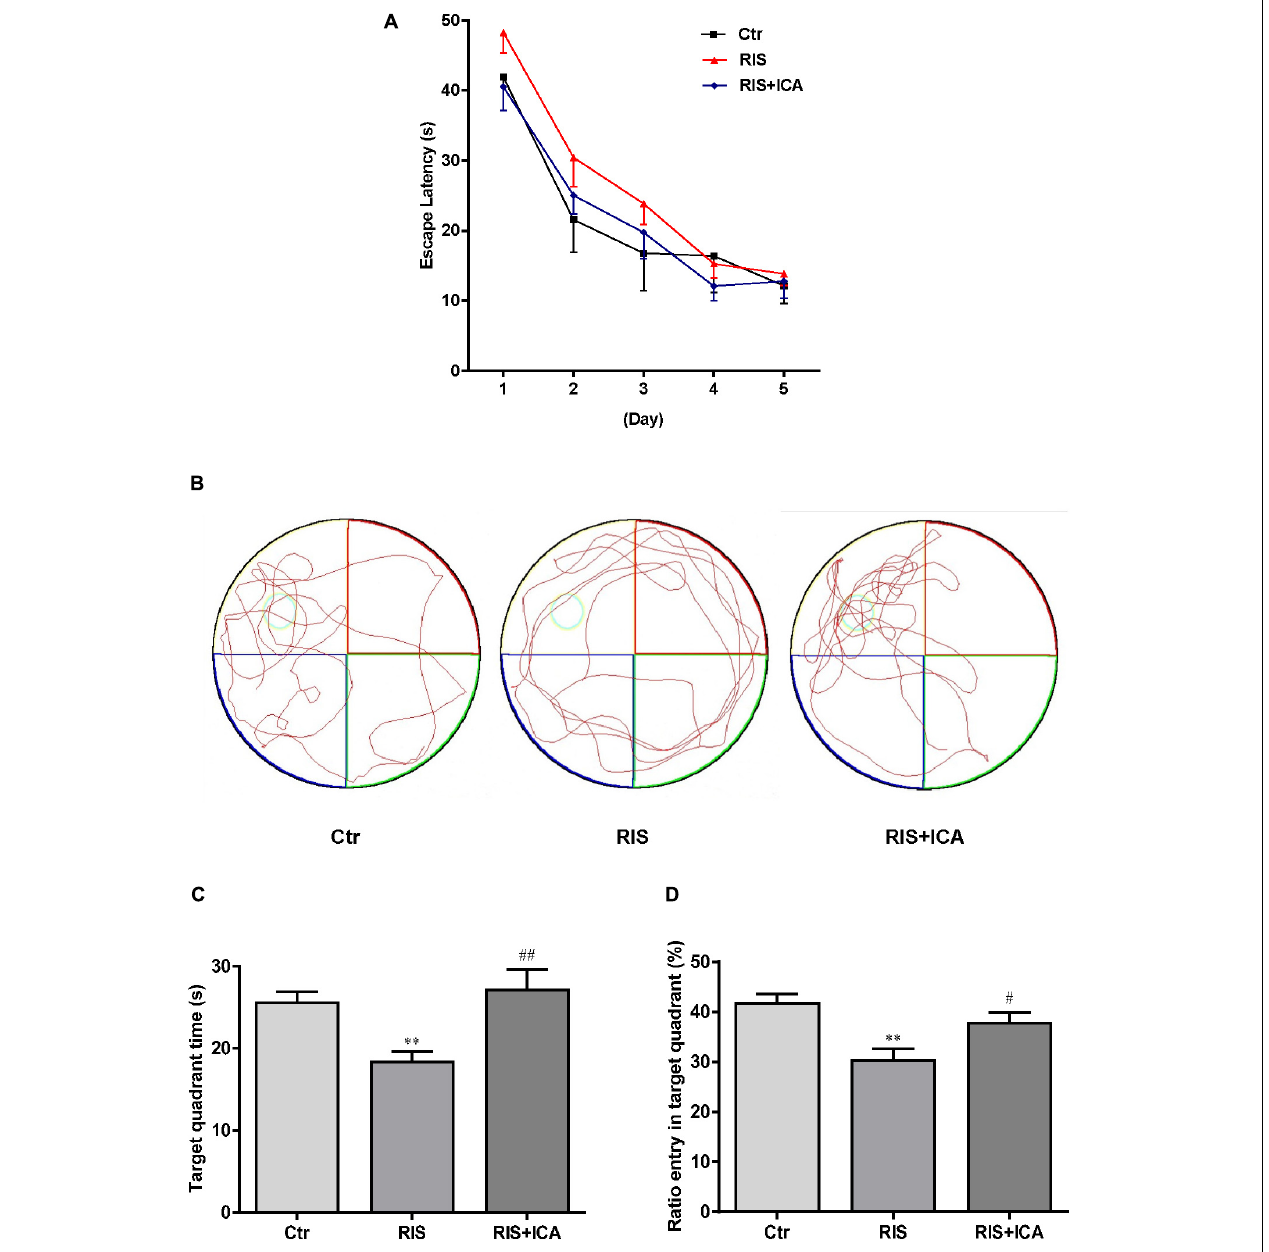
FIGURE 3 | Effect of icariin on learning and memory in MWM. (A) The escape latency of training days. (B) The tracks in the MWM test. (C) Target quadrant time. (D) Ratio entry in the target quadrant. Mice in RIS group spent less time in the target quadrant and showed decreased entry ratio in the target quadrant in the MWM test, in comparison with the control group ( p < 0.01). Icariin administration significantly relieved the behavioral alterations of the mice in the RIS+ICA group, compared with the RIS group. The results are expressed as the mean ± SEM, n = 10. ∗∗ p < 0.01 vs. control group; # p < 0.05, ## p < 0.01 vs. RIS